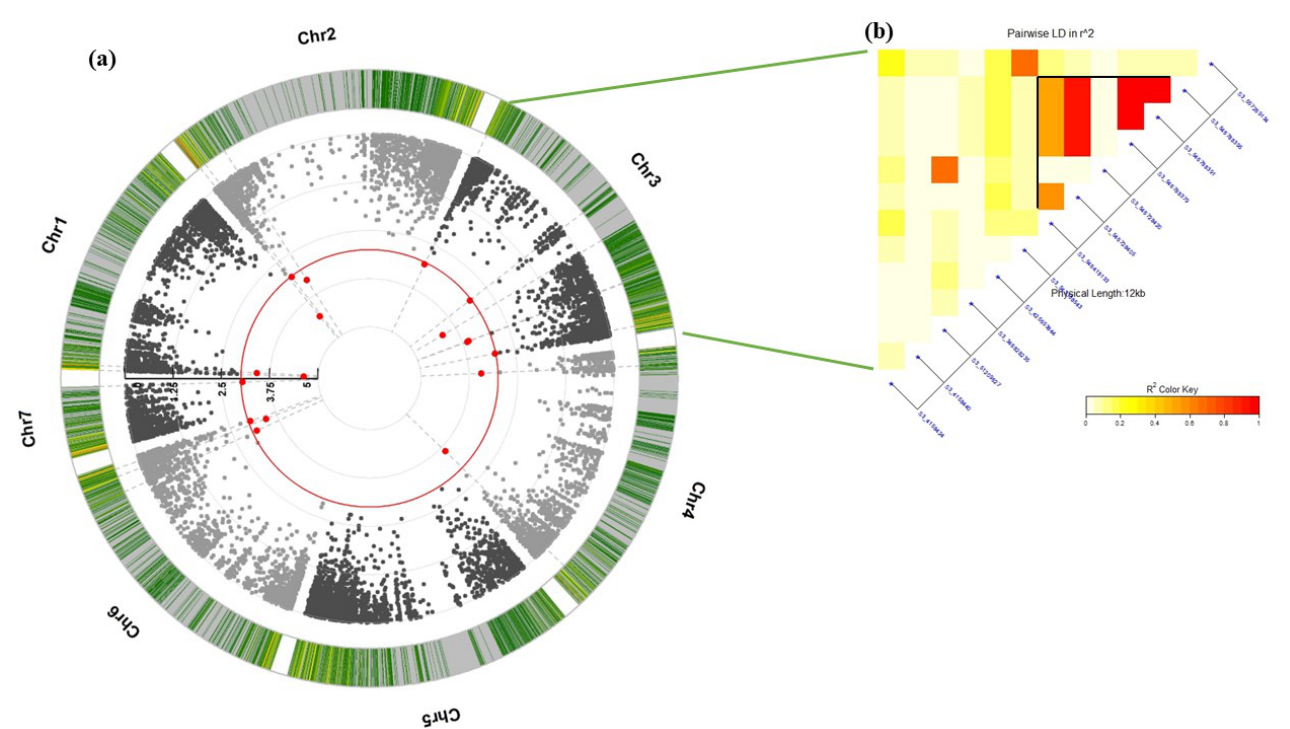
Figure 3. ( a ) Manhattan plot showing the significant SNPs (red circles) associated with LS resistance and their locations on barley chromosomes. The red line indicated the significant threshold at 0.001, ( b ) LD ( r 2 ) among significant SNPs located on chr